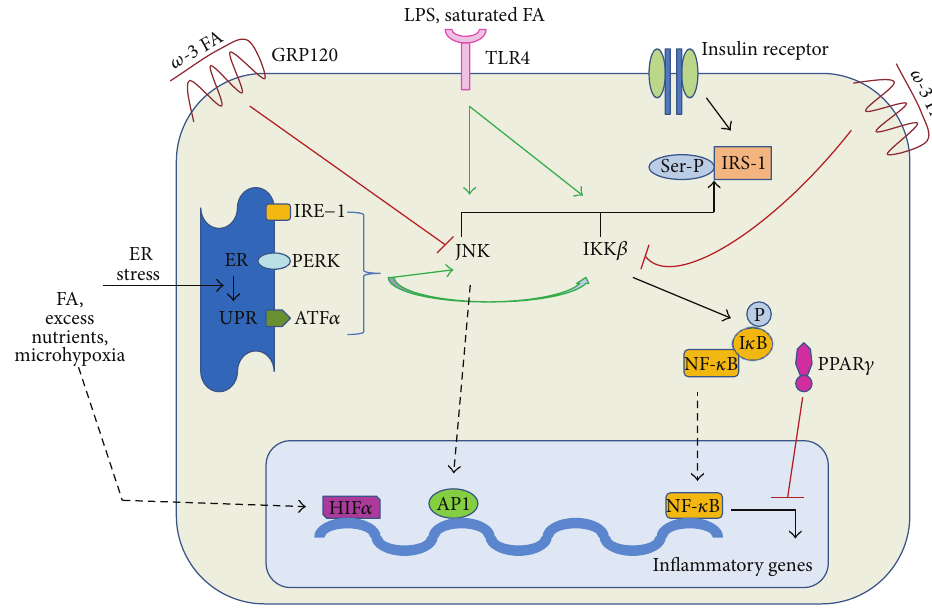
Figure 2: Various signaling pathways promoting or inhibiting inflammatory signaling (green arrows represent activation, and red arrows represent inhibition). Jun N-terminal kinase-1 (JNK1) and inhibitor of kB kinase (IKK 𝛽 ) are inflammatory signaling pathways which promote insulin resistance. Activation of either pathway leads to serine phosphorylation of insulin receptor substrate protein-1 (IRS-1), causing attenuation of insulin action. IKK 𝛽 also phosphorylates inhibitor of nuclear factor- 𝜅 B (I 𝜅 B) which essentially frees nuclear factor- 𝜅 B (NF- 𝜅 B), allowing it to translocate to the nucleus, bind to DNA, and activate inflammatory mediators. JNK1 can also stimulate transcription of inflammatory genes in association with transcription factor activator protein 1 (AP1). Toll-like receptor 4 (TLR4) activation, which normally binds lipopolysaccharides (LPS) and saturated fatty acids (FA), results in activation of JNK and IKK 𝛽 . Endoplasmic reticulum (ER) stress, stimulated by FA, nutrient excess, and microhypoxia, leads to the unfolded protein response (UPR). UPR comprises three main pathways: inositol-requiring enzyme (IRE)-1, protein kinase-like ER kinase (PERK), and activating transcription factor (ATF) 𝛼 which all lead to activation of JNK1 and IKK 𝛽 . Hypoxia also activates the transcription factor hypoxia-inducible factor-1 𝛼 (HIF-1 𝛼 ), which induces expression of various target genes. Conversely, insulin sensitivity is promoted by activation of the omega-3 fatty acid receptor (GRP120) which inhibits JNK1 and IKK 𝛽 . PPAR 𝛾 also promotes insulin sensitivity by interfering with the NF- 𝜅 B and AP1 signaling pathways and subsequent expression of inflammatory